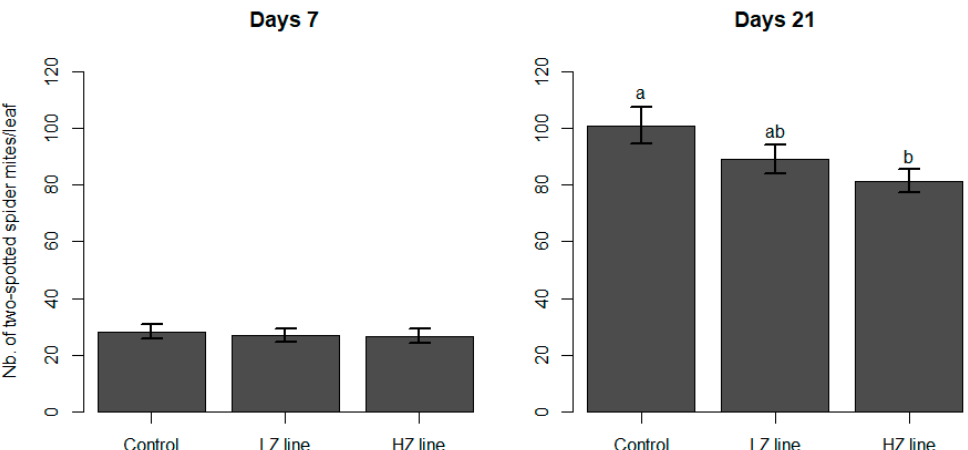
Figure 2. Number of two-spotted spider mites 7 and 21 days after the introduction of four free-ranging mullein bug nymphs (N3 to N5). LZ line refers to the lowly zoophagous isogroup line, whereas HZ indicates the highly-zoophagous line. In the control treatment, no mullein bug nymphs were introduced. Means with the same letter are not statistically different. Error bars indicate standard error.